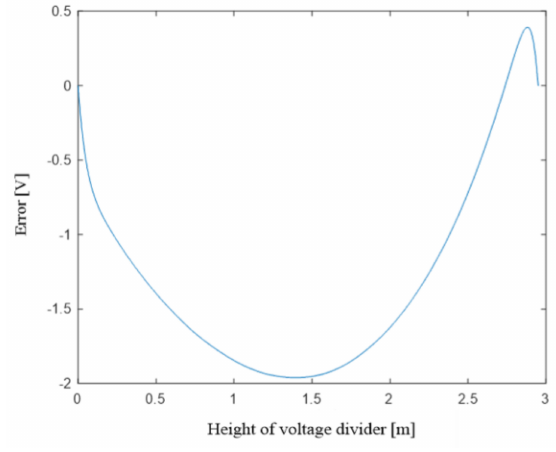
Figure 7. Theoretical error of the voltage divider.